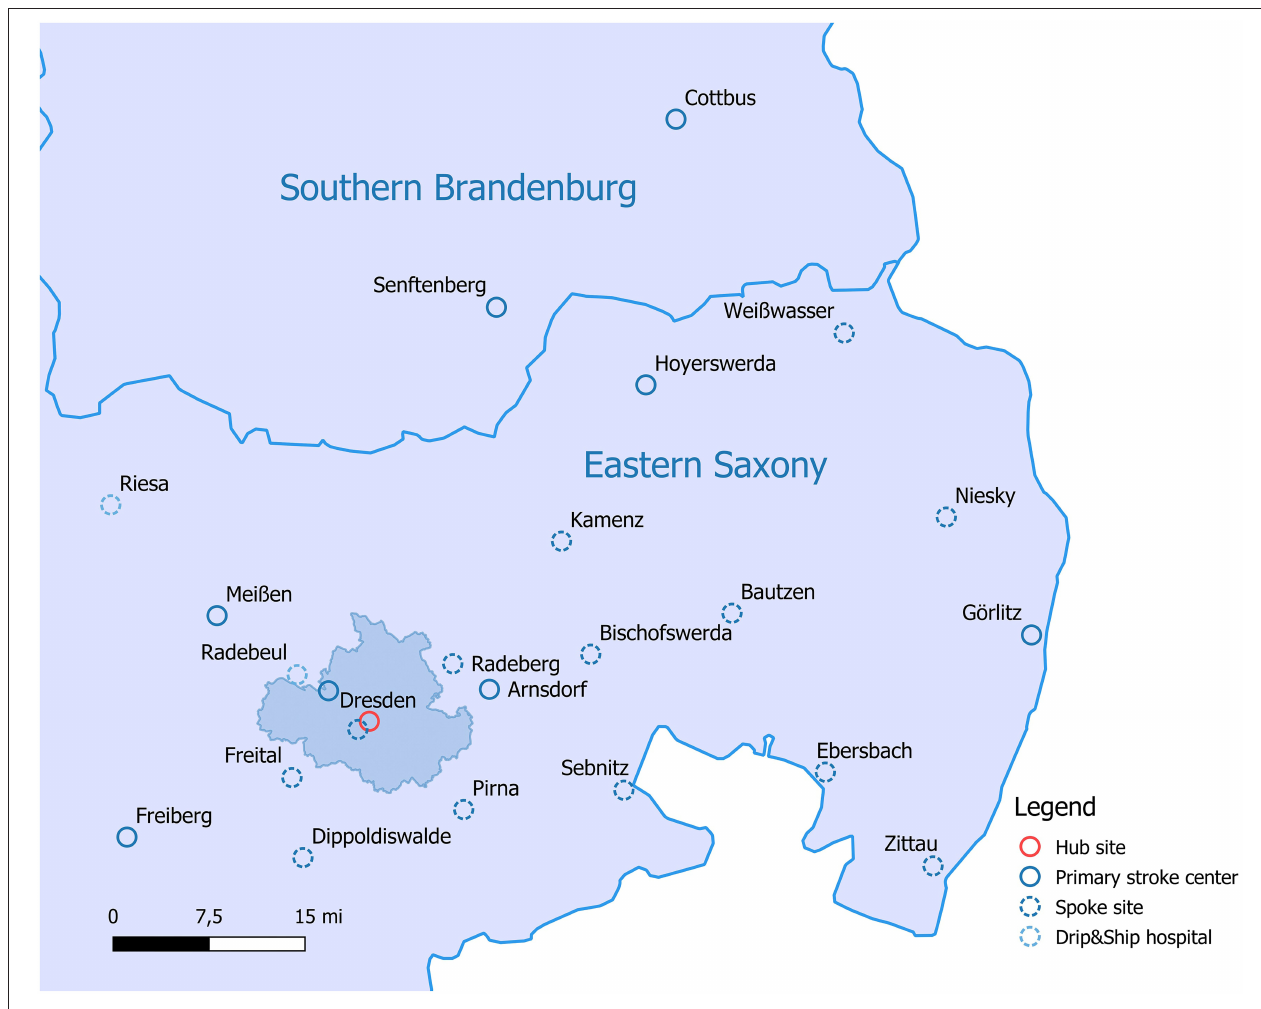
FIGURE 1 | Map of the Stroke East Saxony Telemedical Network in the eastern part of Saxony,